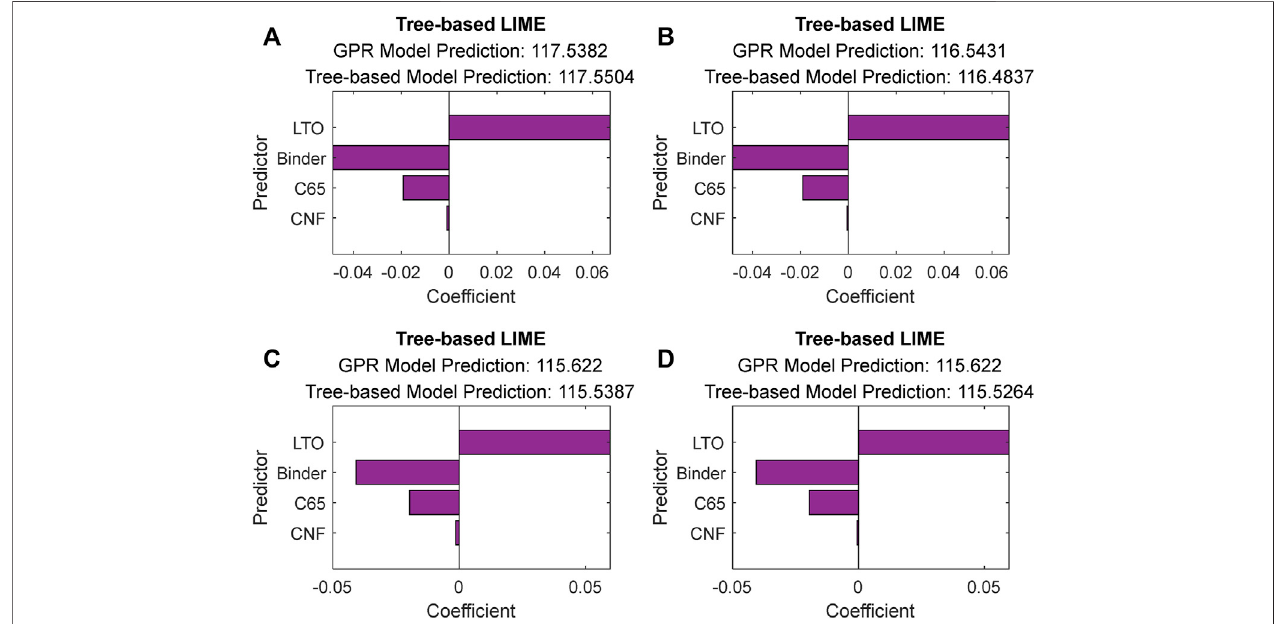
FIGURE 6 | Analysis of local component effects for four randomly selected sample points: (A) Sample 1, (B) Sample 2, (C) Sample 3, and (D) Sample 4.